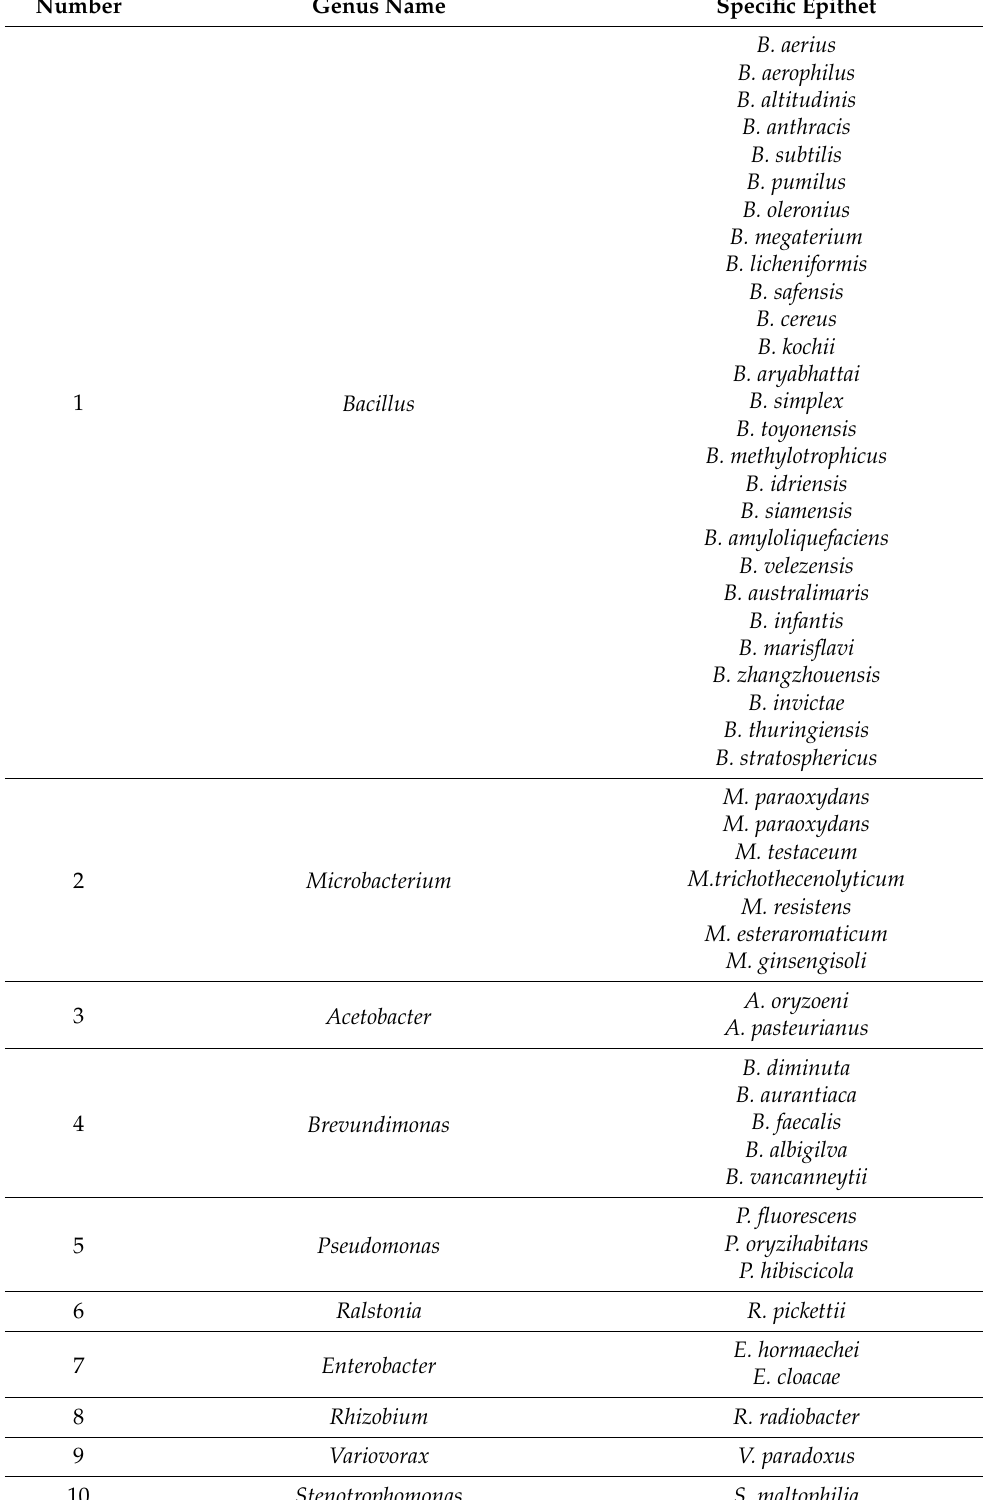
Table 3. The results of isolation and identification of fermented grains by